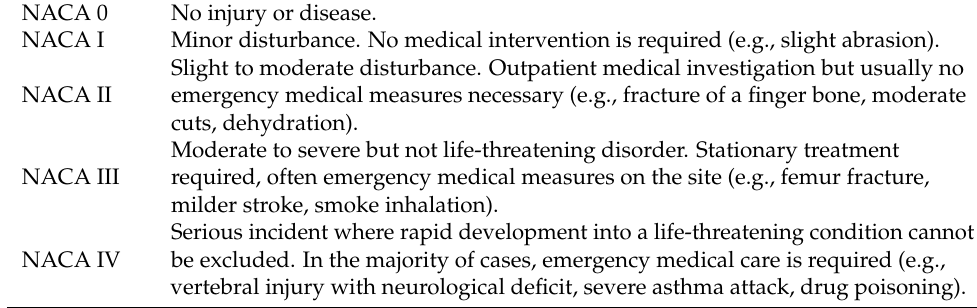
Table 1. Description of NACA-Score (National Advisory Committee for Aeronautics Score)